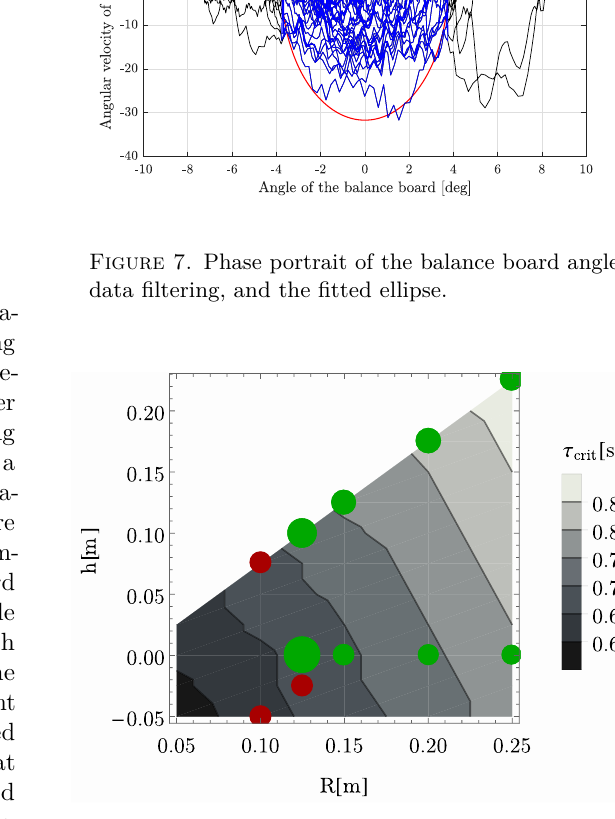
Figure 8. Stabilizability